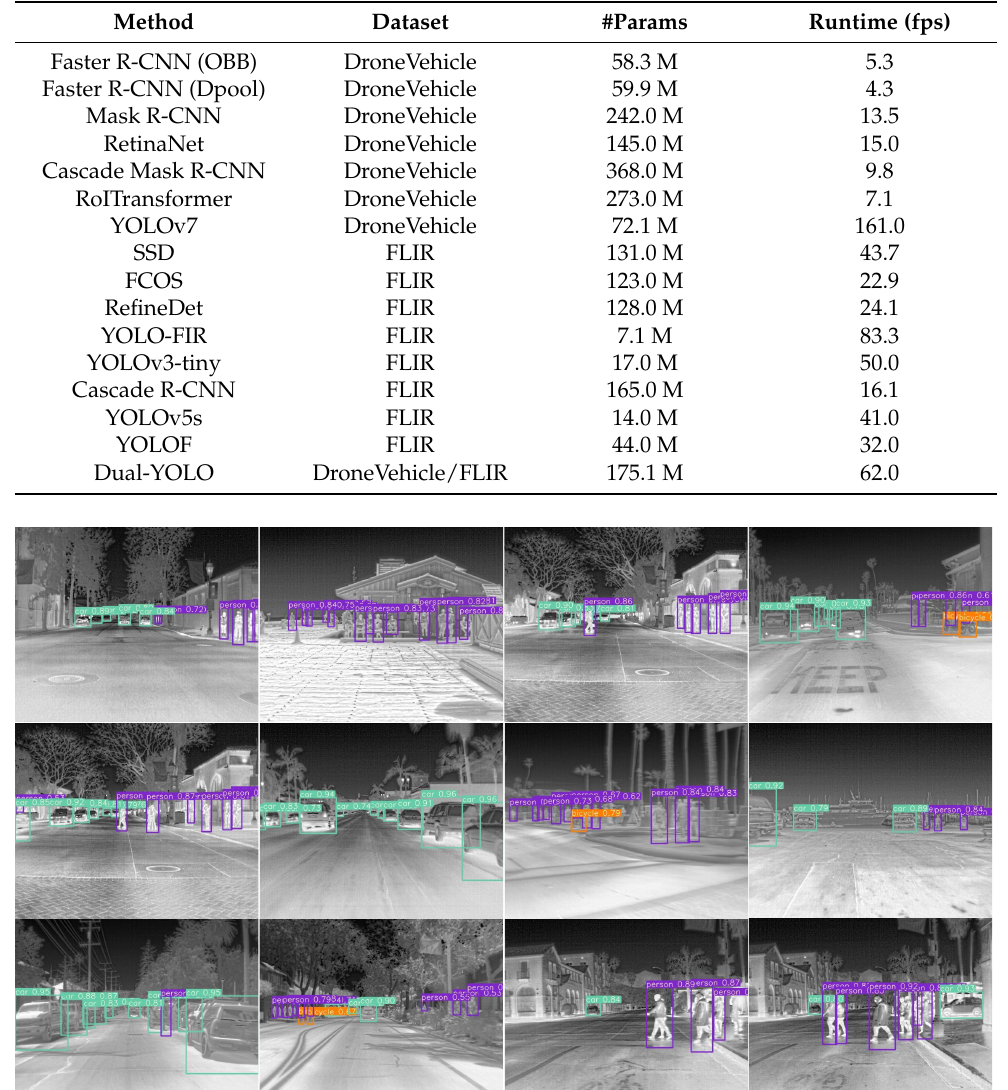
Table 7. Model complexity and runtime comparison of Dual-YOLO and the plain counterparts.